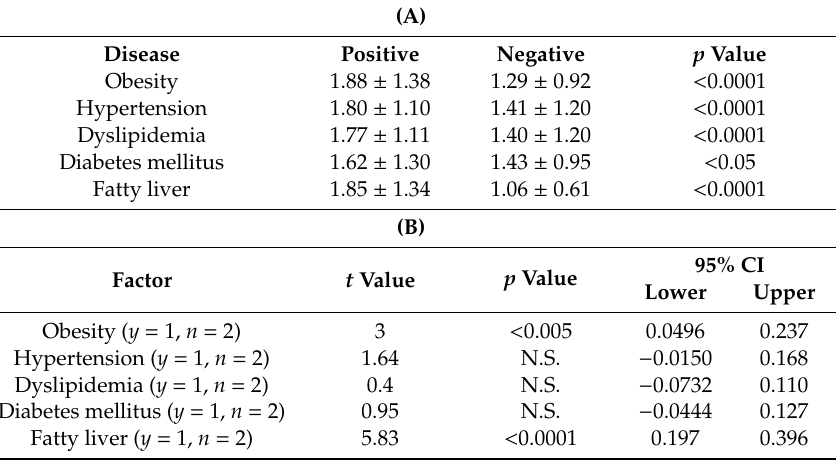
Table 3. Relationship between serum M2BP levels and metabolic risk factors. ( A ) Comparisons between serum M2BP levels and each metabolic syndrome–related disease at baseline. ( B ) Multiple logistic regression analysis of factors associated with serum M2BP levels at baseline.